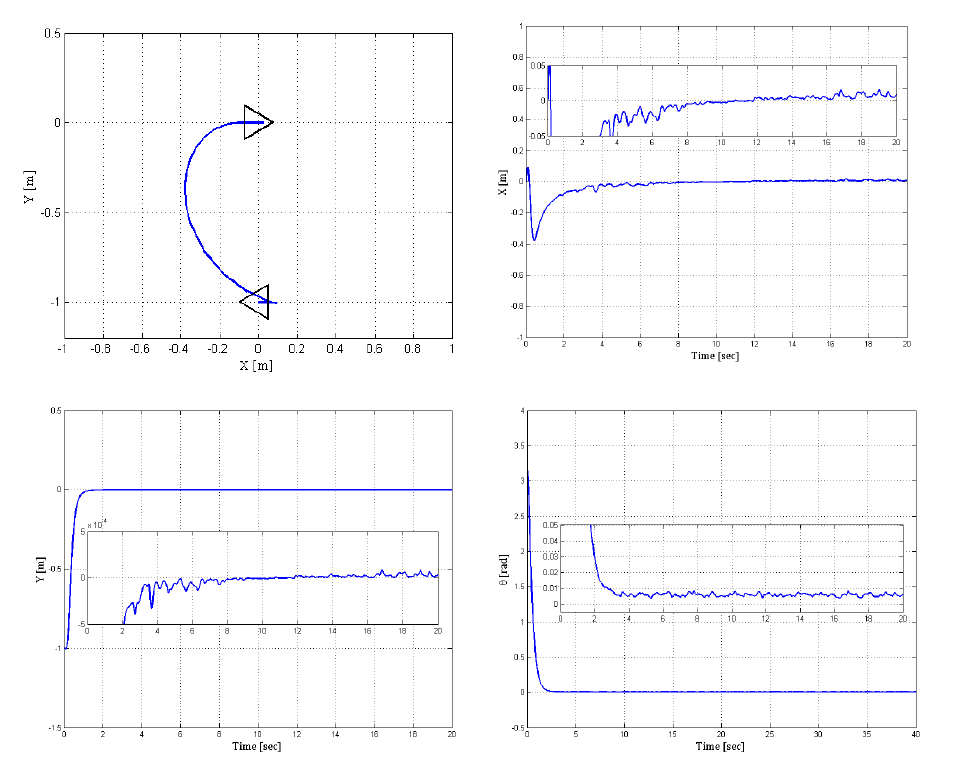
Figure 9. Posture stabilization with White Noise (parallel parking with initial heading angle at 180 ◦ ).